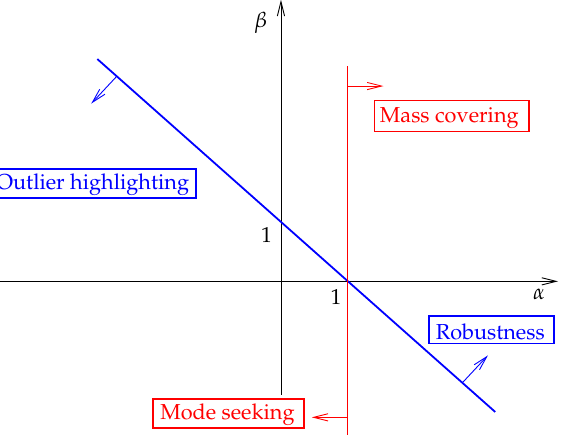
Figure 1. Character of the variational objective obtained by varying the ABD hyperparameters α and β